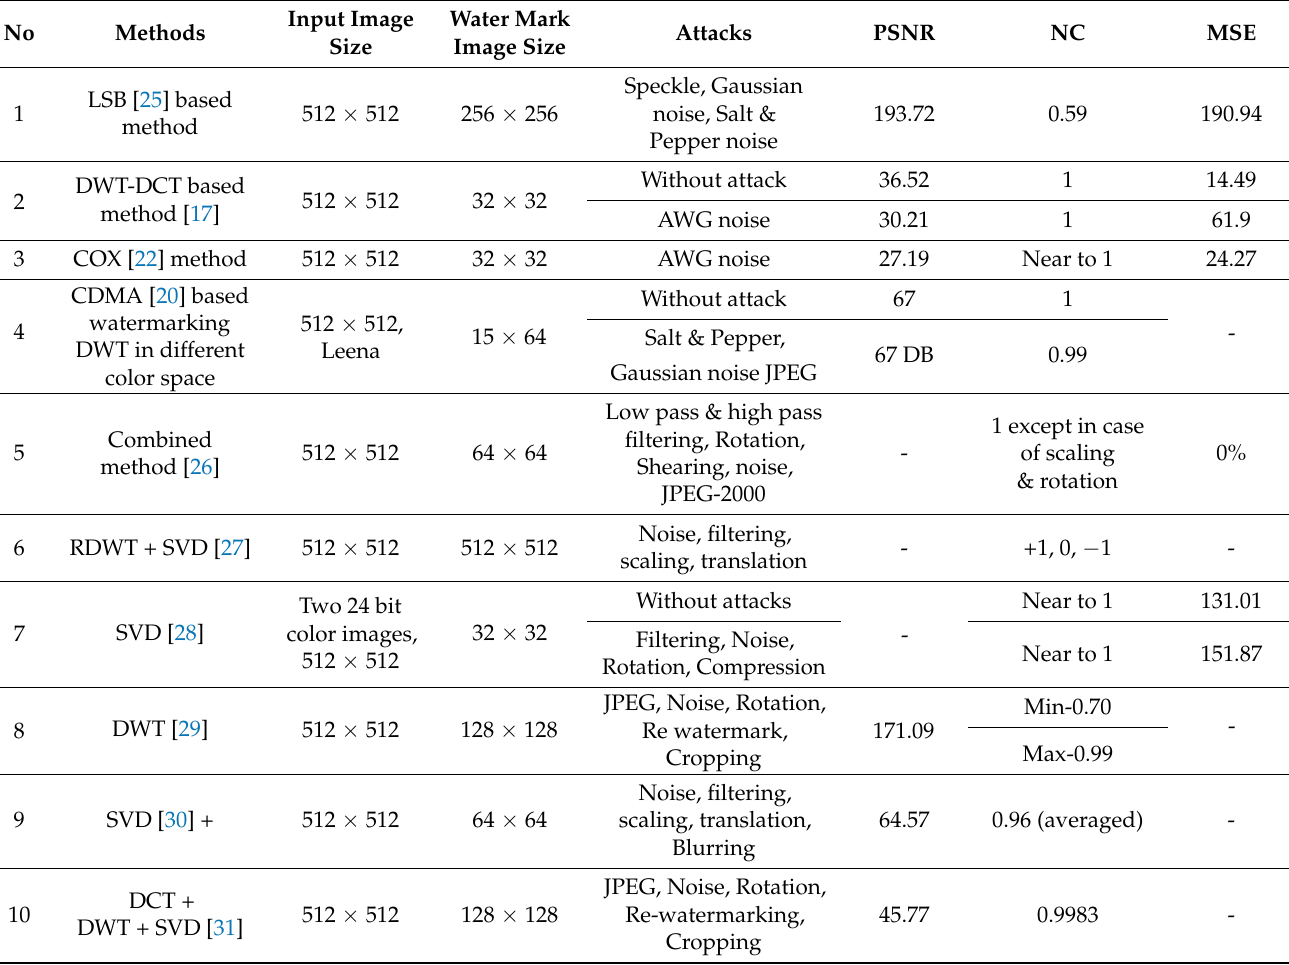
Table 1. Comparison of existing methods with mathematical